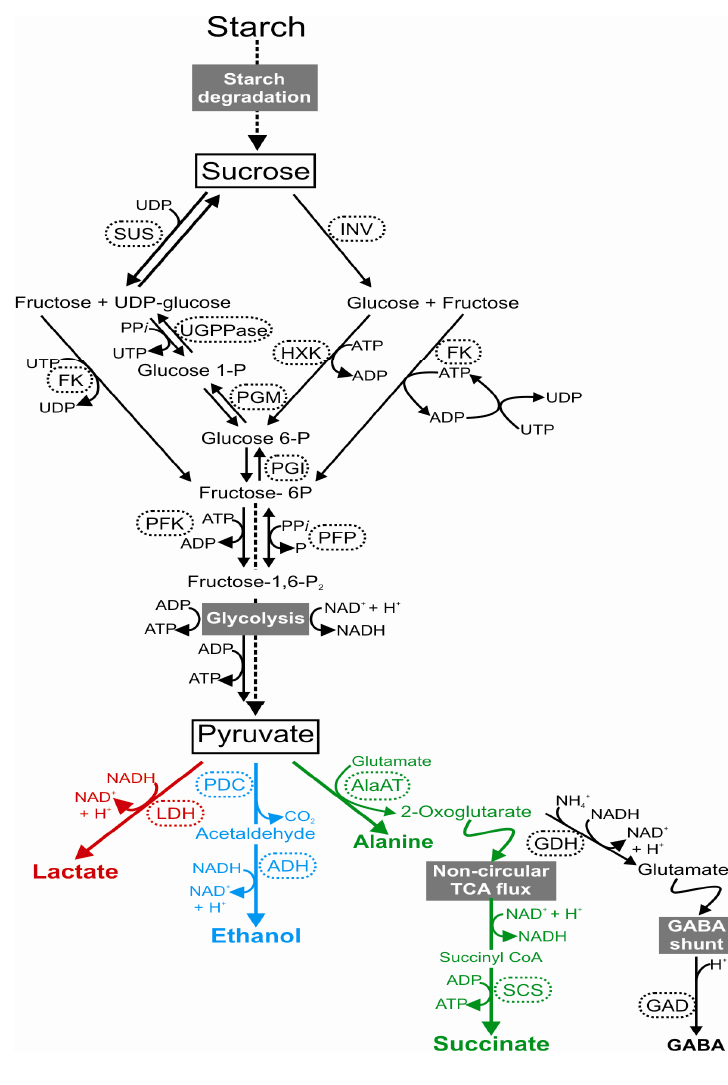
pathways and other metabolites involved in this mechanism are indicated in